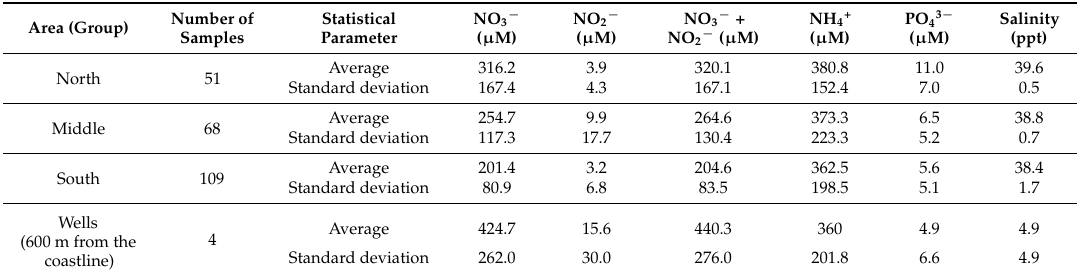
Table 2. The number of coastal shallow groundwater nutrient samples and average concentrations in different parts of the Gaza